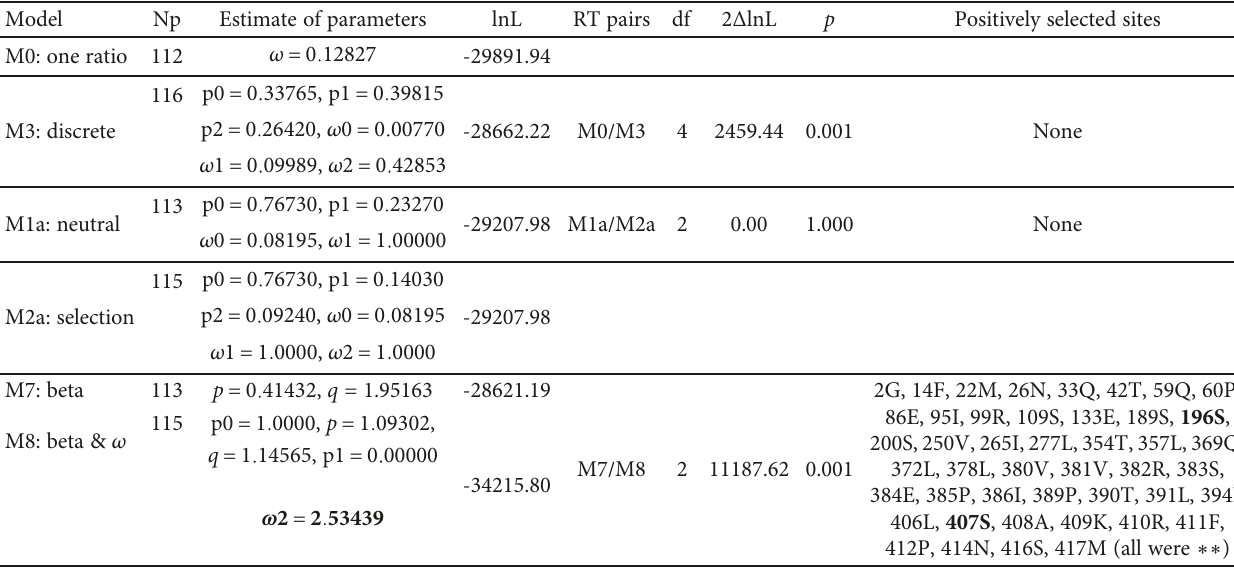
Table 2: Parameter estimation and likelihood ratio tests for the site model.